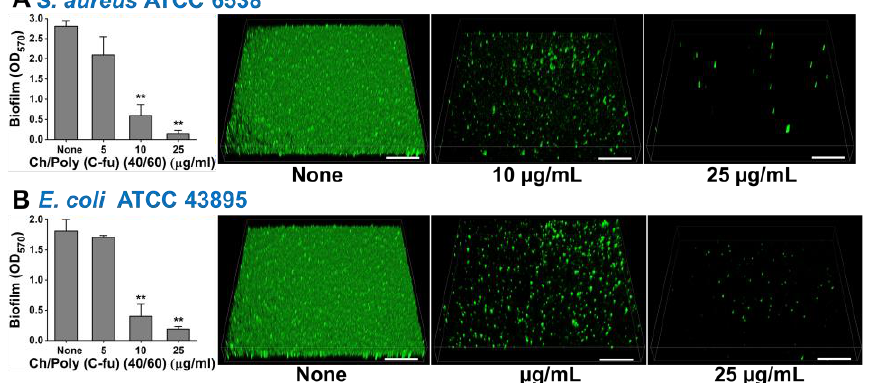
Figure 7. Effects of Ch/Poly (C-fu) (40/60) on S. aureus , and E. coli biofilm formation. Biofilm formations by Staphylococcus aureus ATCC 6538 ( A ), and Escherichia coli ATCC 43895 ( B ) quantified in the presence of Ch/Poly (C-fu) (40/60) after 24 h in 96-well plates. **, p < 0.01 vs. non-treated controls. Biofilm formation was observed by confocal laser microscopy. Scale bars represent 100 μ m.